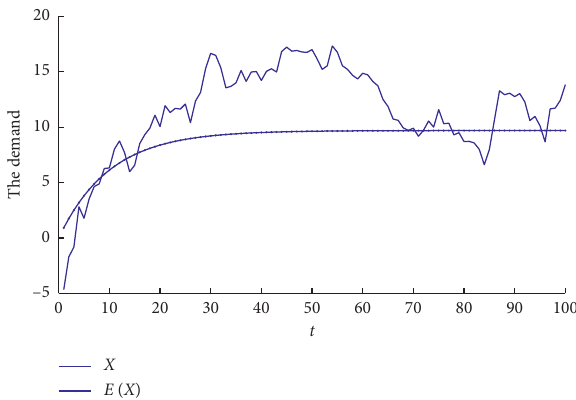
Figure 6: The changing effects of demand and demand expecta- tions over